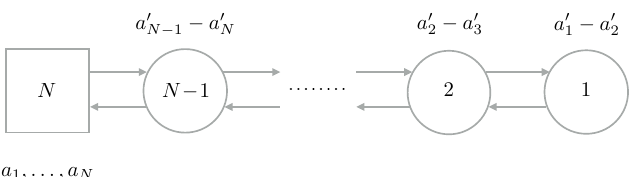
Figure 13 . A quiver description of T ( g ) with hypermultiplet mass parameters ( a